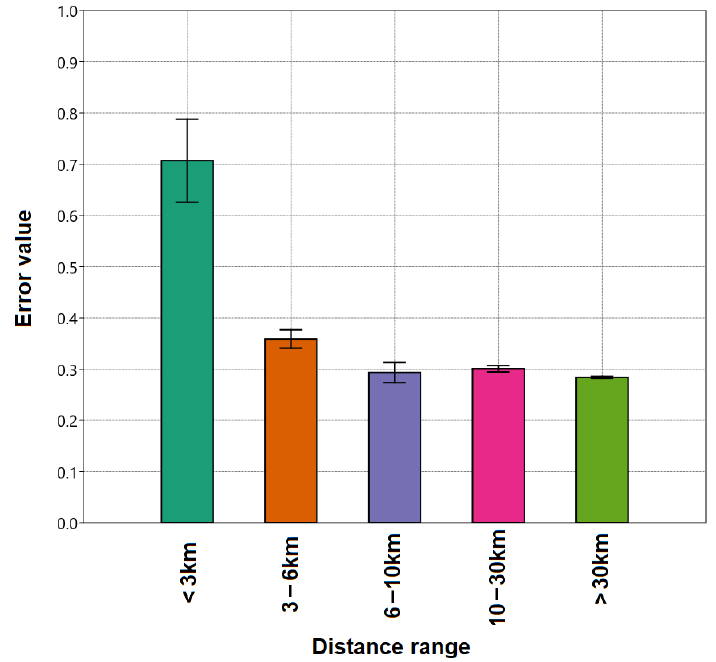
Figure 3. Bar plot with errors representing relative error values in the different distance range.